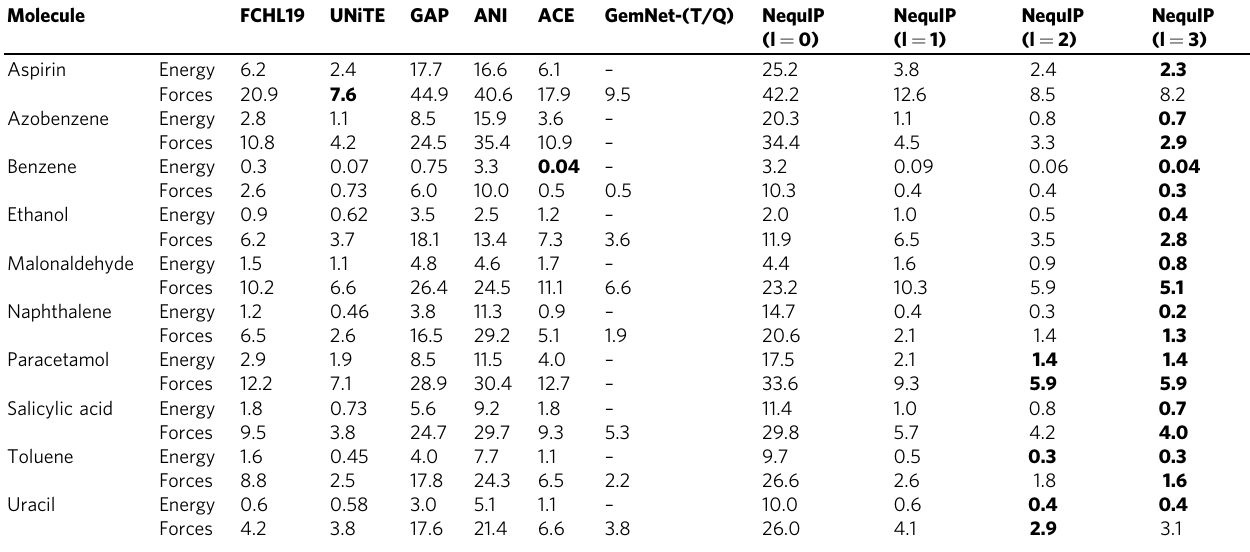
Table 2 Energy and Force MAE for molecules on the revised MD-17 data set, reported in units of [meV] and [meV/ Å ], respectively, and a training budget of 1000 reference con fi